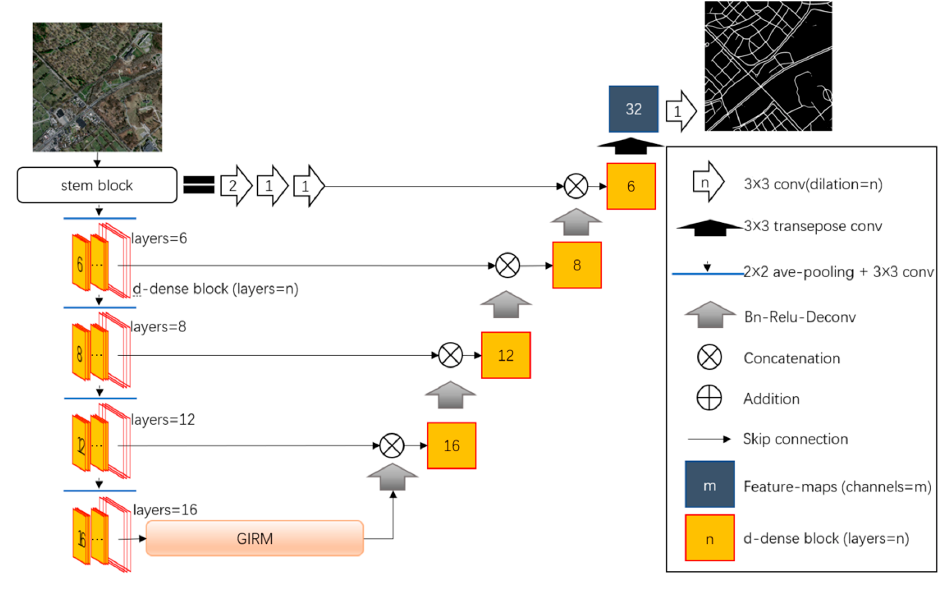
Figure 2. The construction of the SDG-DenseNet.